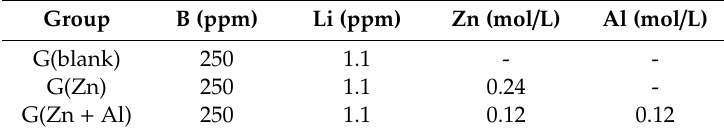
Table 2. The ionic compositions of the experimental